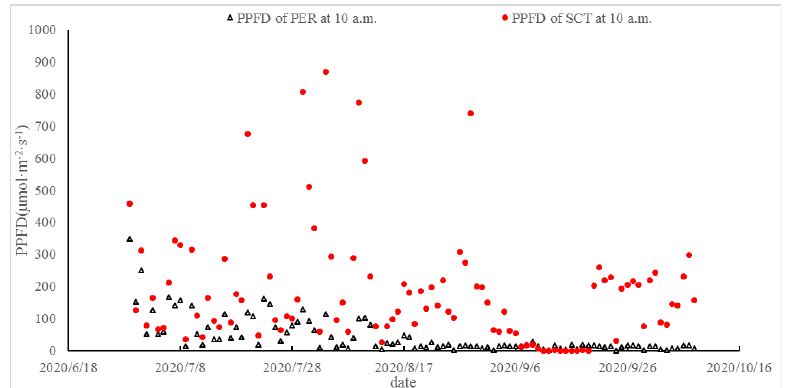
Figure 2. PPFD (photosynthetic photon flux density) around grape clusters of PER (pergola) and SCT (single-curtain training system) from July to October. (single-curtain training system) from July to